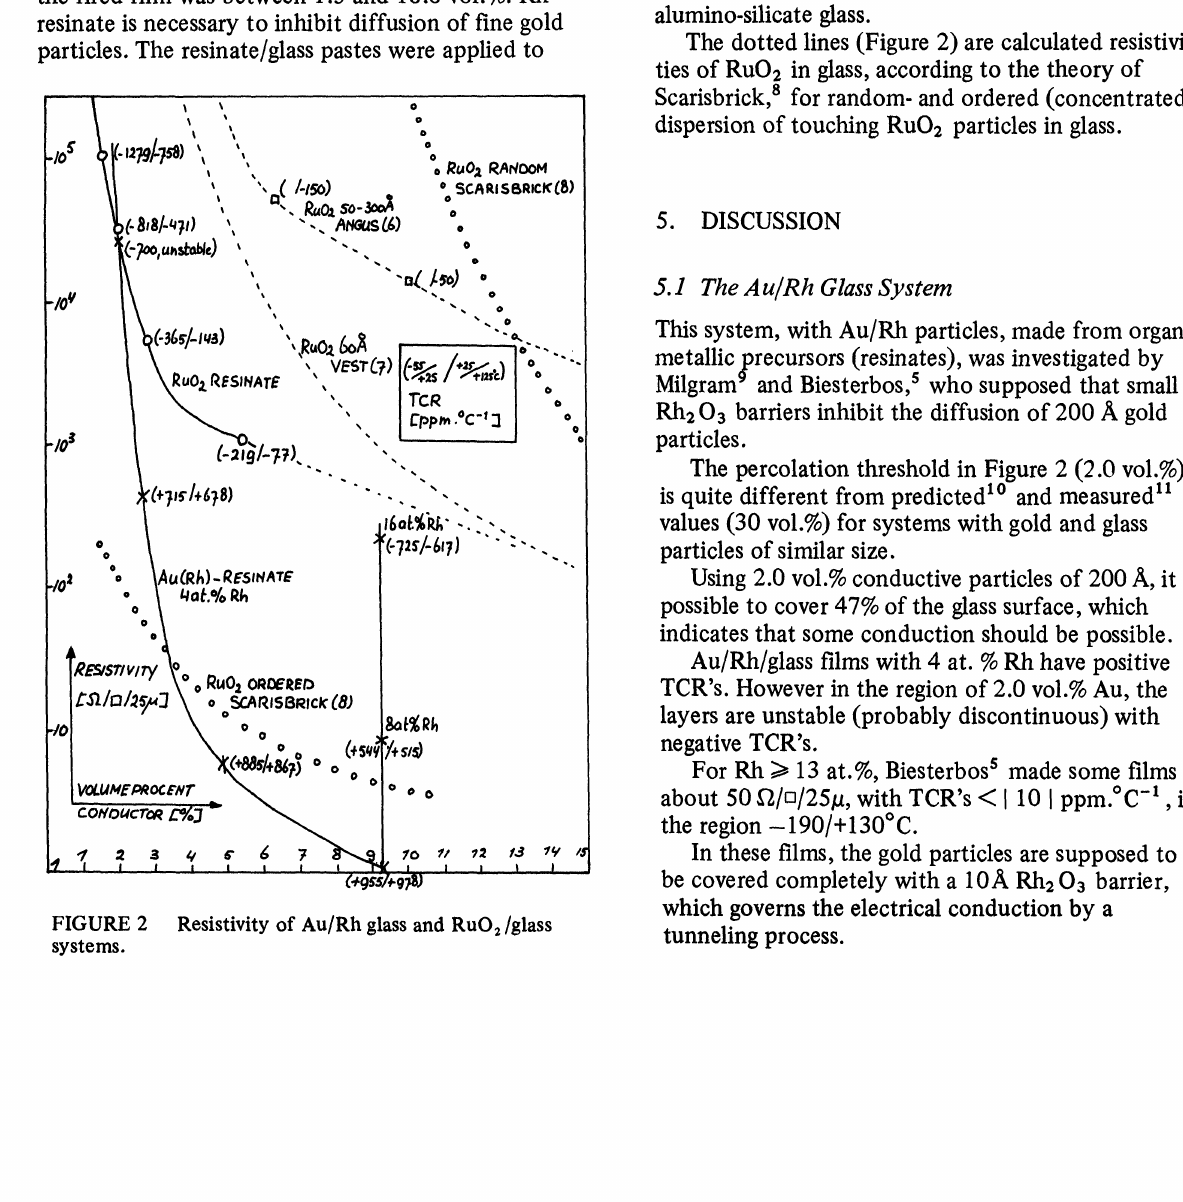
FIGURE 2 Resistivity of Au/Rh glass and RuO2/glass